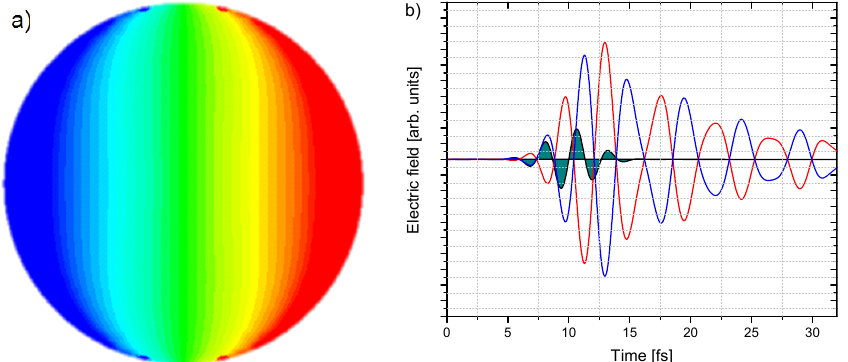
Figure 3. ( a ) Electric near field at the surface of a 1nm thick gold disk excited with monochromatic light at 1390nm and ( b ) the temporal evolution of the integrated field over the left and right half disk after excitation with a broadband pulse together with the excitation